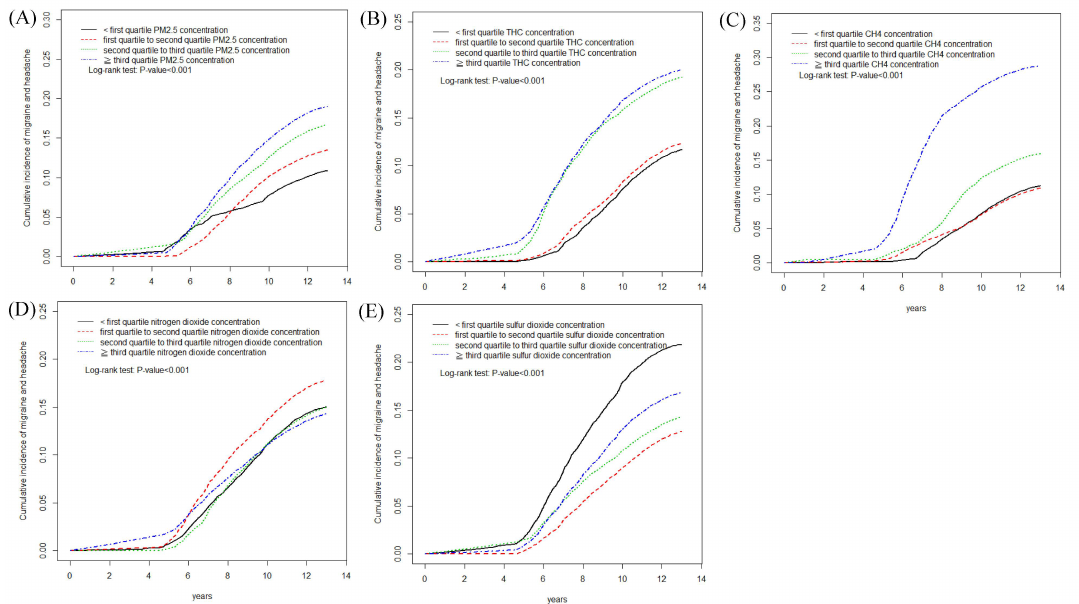
Figure 2. Kaplan–Meier curves of the accumulative incidence rate of recurrent headaches during the follow-up period among the four quartiles of each air pollutant. ( A ) PM 2.5 ( B ) THC ( C ) CH 4 ( D ) SO 2 ( E ) NO 2 .